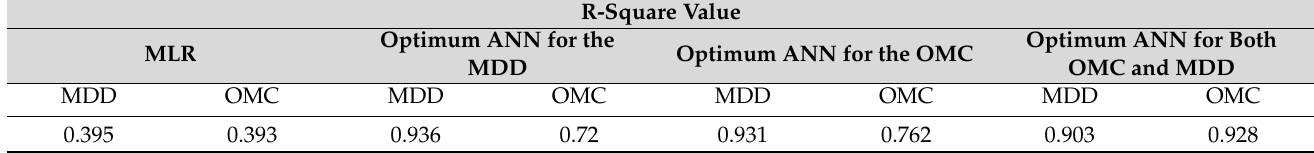
Table 11. R 2 values of the different ANNs proposed and the MLR technique.